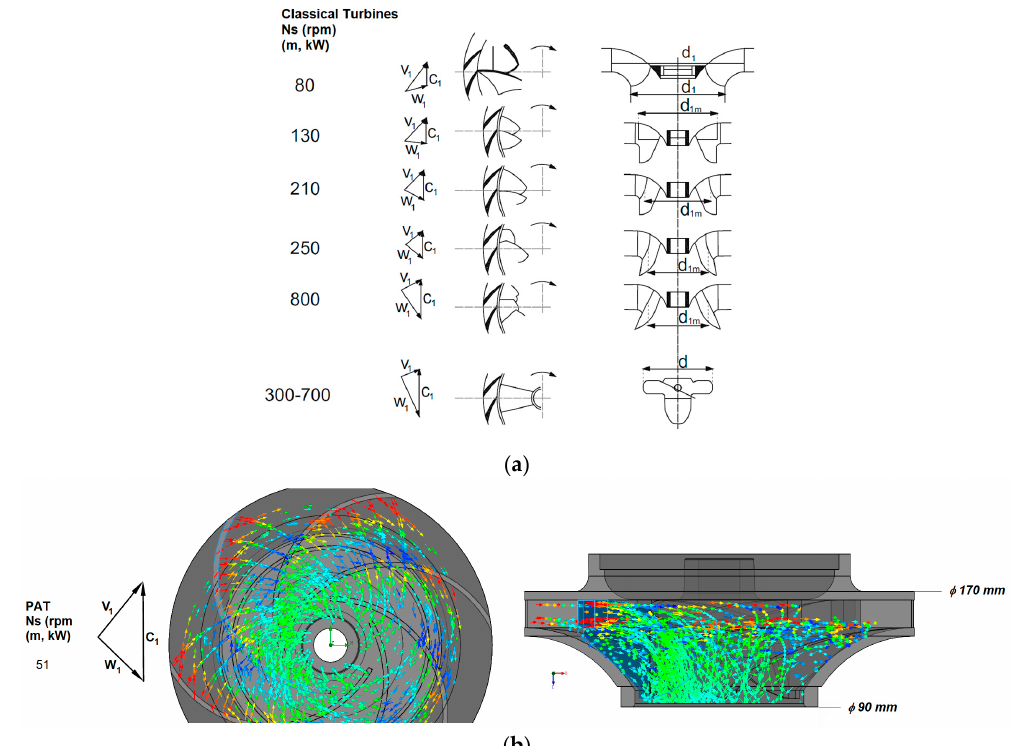
Figure 9. Velocity components: ( a ) Classical turbines inlet triangle of velocities for different Ns (m, kW) adapted from [26]; ( b ) radial PAT flow impeller for Ns = 51 rpm (m, kW), in front and cross section view. Reproduced with permission from [26].